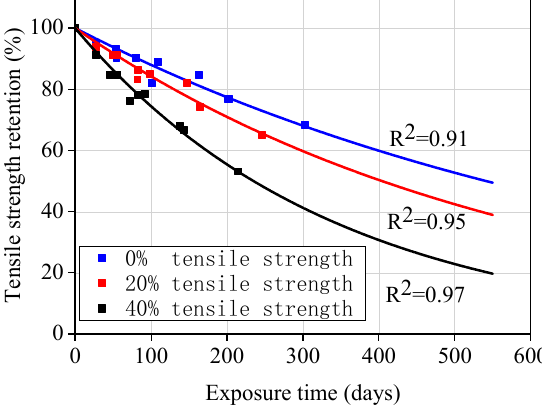
Figure 14. Master curves for GFRP bars exposed to concrete pore solutions at 20 °C. Table 9. Coefficients of the regression equations for the master curves.